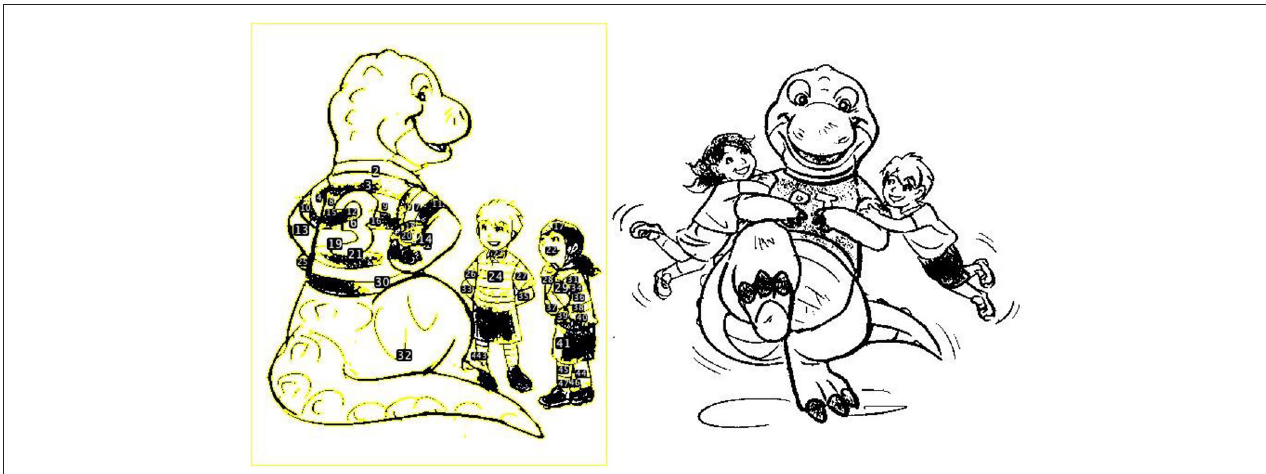
FIGURE 1 | The example illustration processed by the ImageJ. The example illustration is not a part of any picture books we coded, but the illustration, “Do dinosaurs play rugby?” by Stevie Mahardhika (licensed under CC BY-NC 4.0) from the Creative Commons was used as an example due to the copyrights of picture books. The image was processed to meet the requirements of the computer program, ImageJ. The example included two image segments that would be coded separately by the ImageJ and the human coders. The yellow lines highlight the particles coded by the ImageJ with the number on each particle.